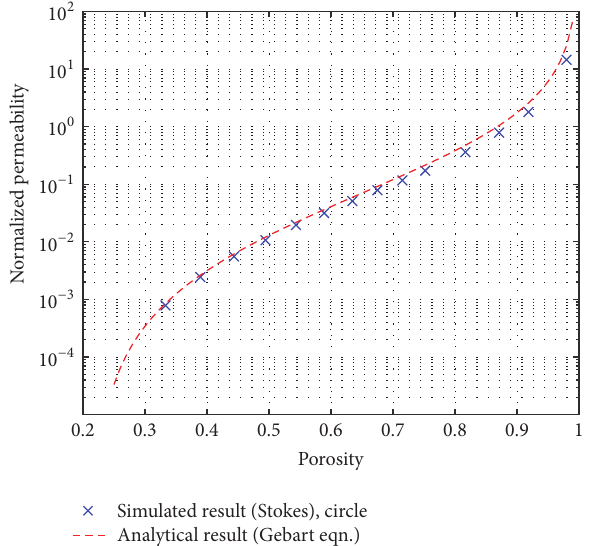
Simulated result (Stokes), circle Analytical result (Gebart eqn.) Figure 2: Permeability-porosity trend for in-line array of circles (i.e., infinitely long cylinders). Permeability units are nondimen- sional (i.e., unit length × unit length). The permeability is isotropic and is normalized by 𝑟 2 , where 𝑟 is the solid circle radius. Gebart’s [47] analytical solution was given in